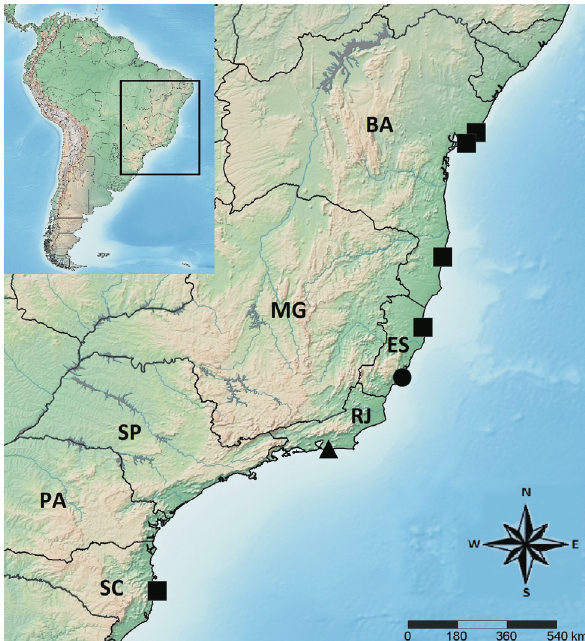
Figure 17. Geographic distribution records of Alpaida toninho sp. nov. and A.teresinha sp. nov. in the Brazilian coast. (square) A. toninho , (circle) A. teresinha , (triangle) both